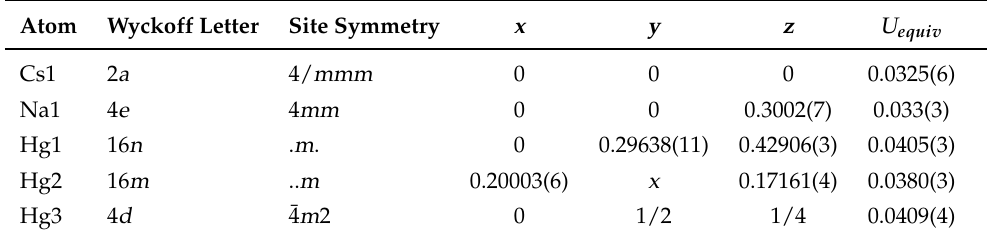
Table 3. Standardised fractional atomic coordinates [57] and equivalent isotropic displacement parameters (Å 2 ) for CsNa 2 Hg 18 as a result of single-crystal structure refinement. The equivalent isotropic displacement parameter is defined as 1/3 of the trace of the anisotropic displacement tensor. All standard deviations are given in parentheses in units of the last digit.